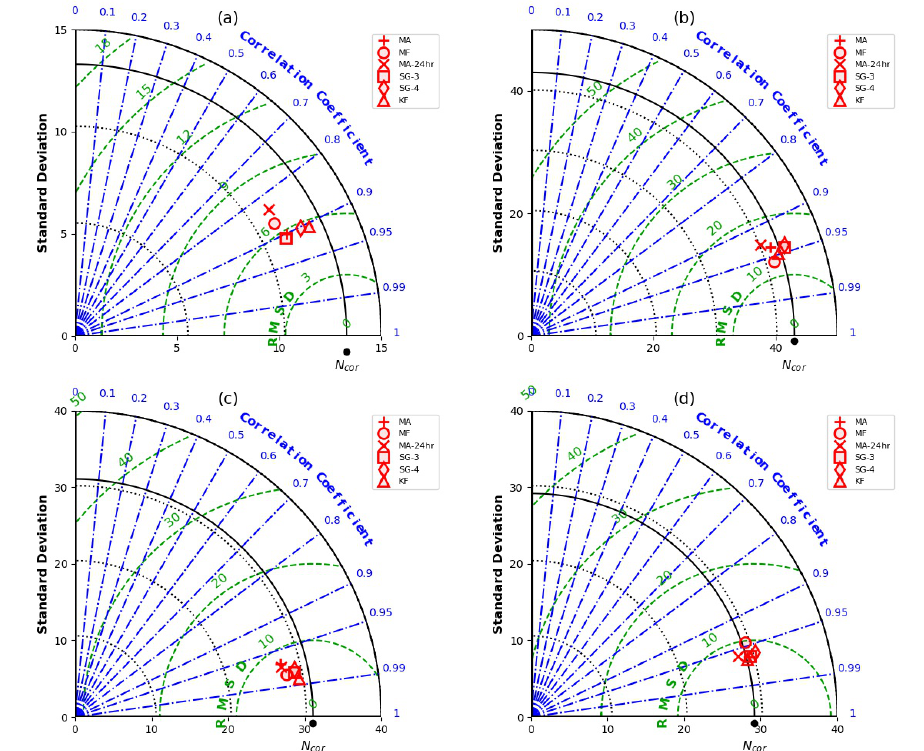
Figure 8. Performance of the optimal window size of the different filtering approaches at SMEAR II ( a ), Gorigo ( b ), Rollesbroich ( c ) and Conde ( d ). The original neutron flux is denoted by the black